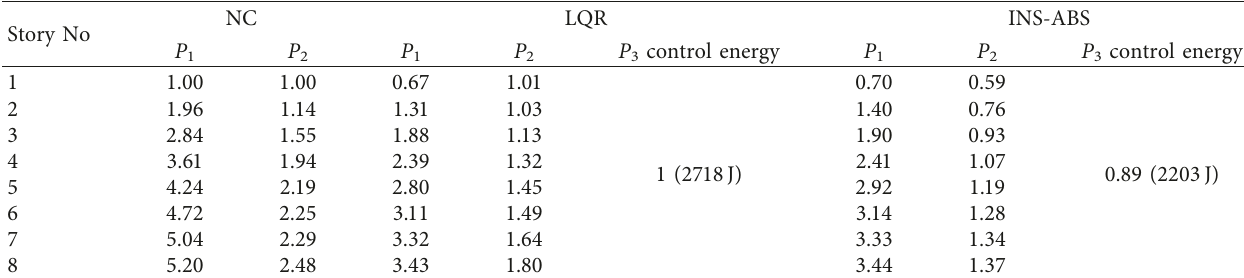
Figure 5: Top story displacement and control forces for Erzincane earthquake. Table 4: Comparison measures for Erzincan